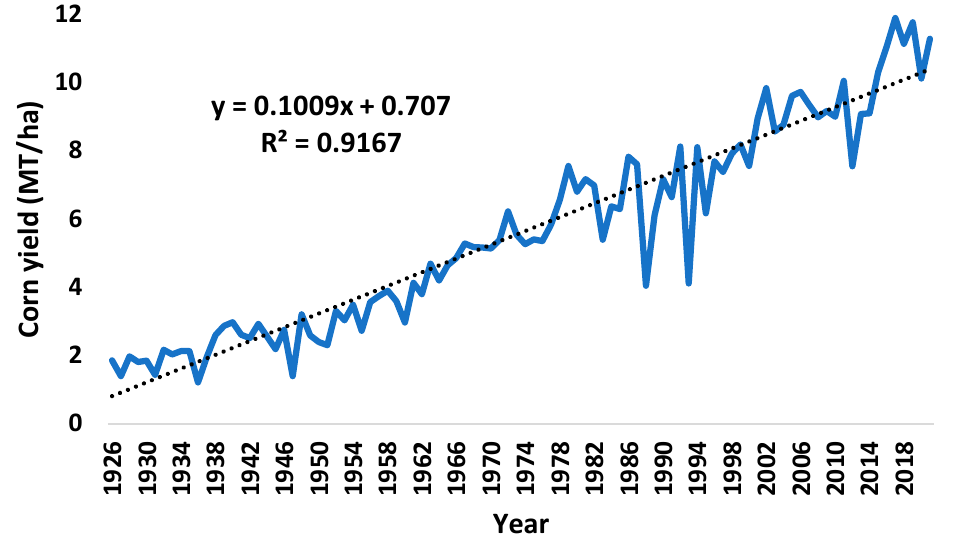
Figure 7. Long ‐ term trend in historical corn yields for Buchanan County, Iowa. Figure 7. Long-term trend in historical corn yields for Buchanan County, Iowa.